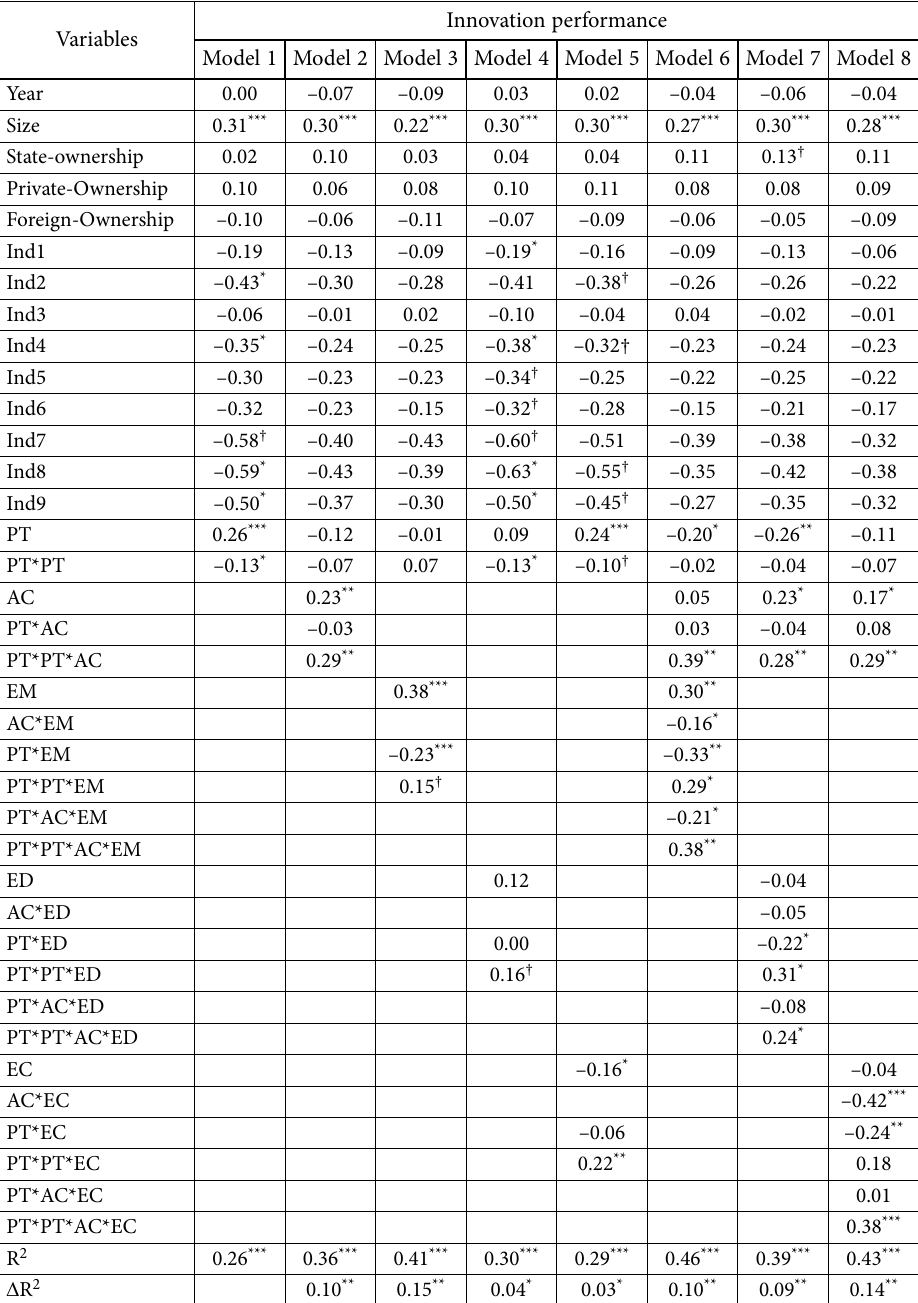
Table 4. Regression analyses